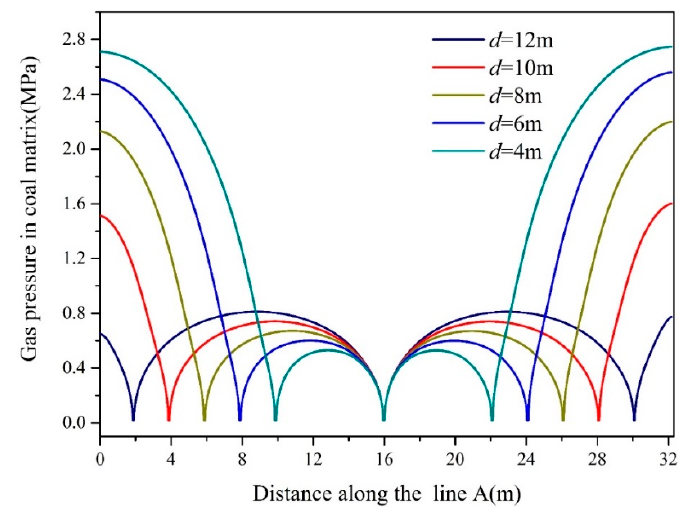
Figure 10. Gas pressure distribution of the matrix along line A under different directional distance after 284 days extraction.